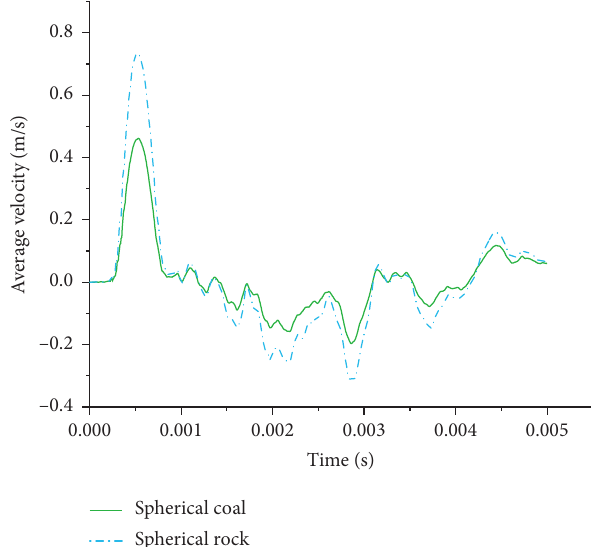
Figure 7: Average velocity in the tail beam collision contact zone under the coal-rock particle